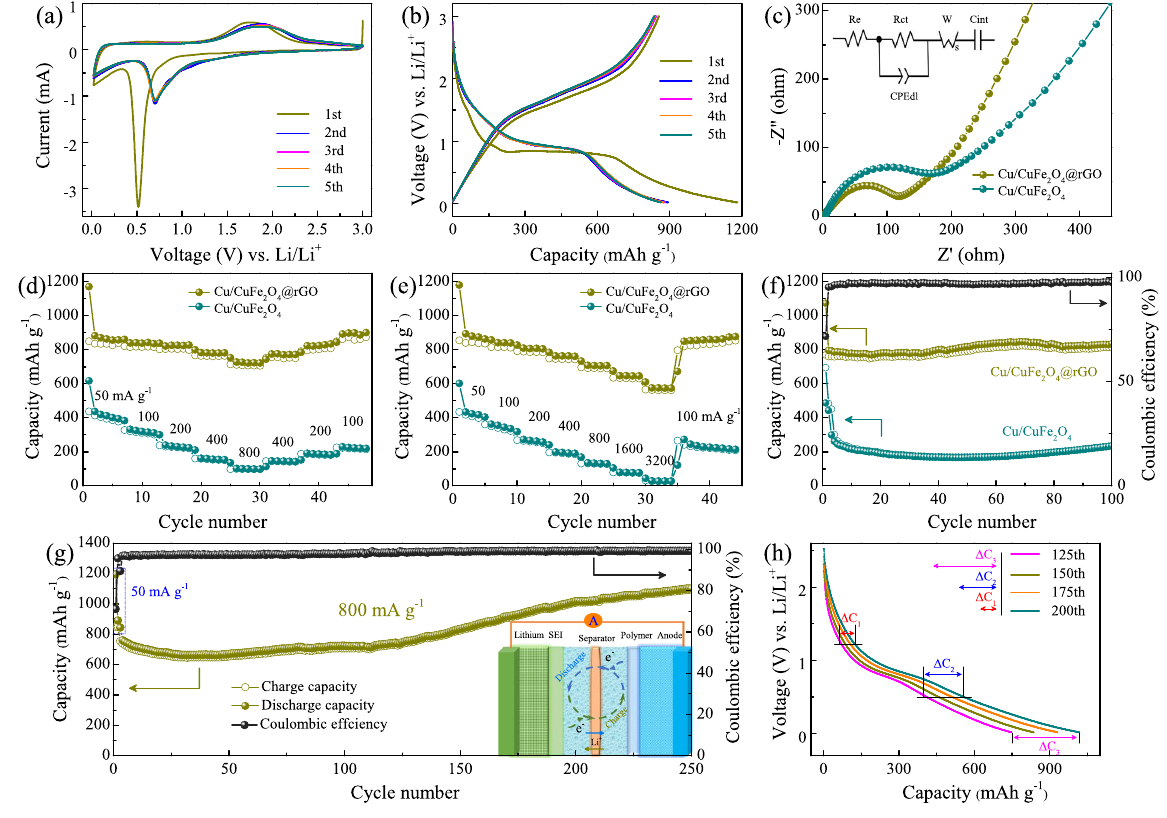
Figure 7. ( a ) CV curves and ( b ) charge/discharge voltage profiles of Cu/CuFe 2 O 4 @rGO at 50 mA g − 1 for the initial five cycles. ( c ) Nyquist plots and equivalent circuit of Cu/CuFe 2 O 4 and Cu/CuFe 2 O 4 @rGO. ( d ) Rate capabilities of Cu/CuFe 2 O 4 @rGO and Cu/CuFe 2 O 4 at different current density. ( e ) Rate capabilities of Cu/ CuFe CuFe 2 O 4 @rGO and Cu/CuFe 2 O 4 at 200 mA g − 1 for 100 cycles. ( g ) Cycling performance of Cu/CuFe 2 O 4 @rGO at 800 mA g − 1 for 250 cycles, inset shows the schematic illustration of the half-cell structure during cycling. ( h ) Selected discharge voltage profiles of Cu/CuFe 2 O 4 @rGO at 800 mA g − 1